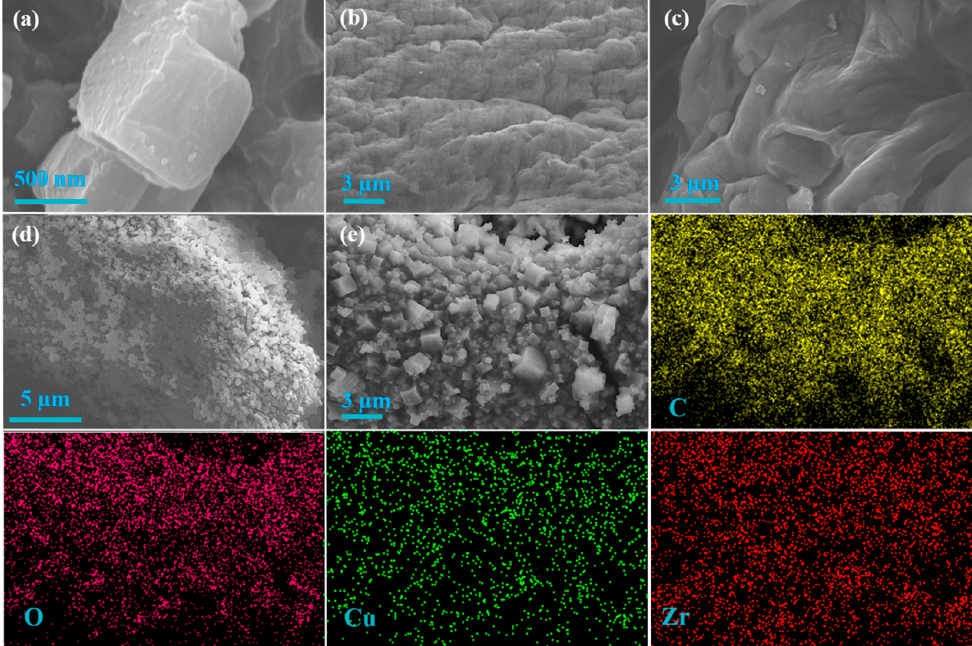
Figure 2. SEM images of MOF-525 ( a ), Alg-Cu ( b ), and Alg-Cu@GO ( c ); SEM images of